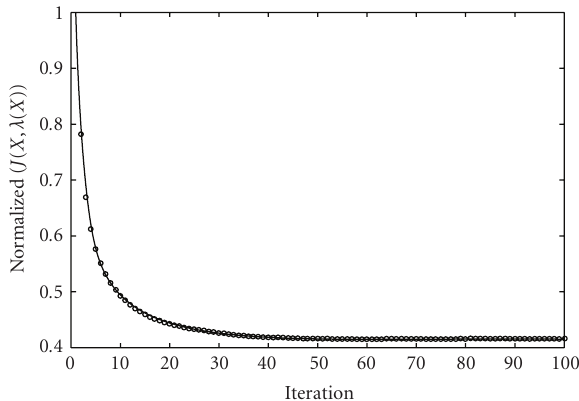
Figure 3: Convergence of the cost function for Car